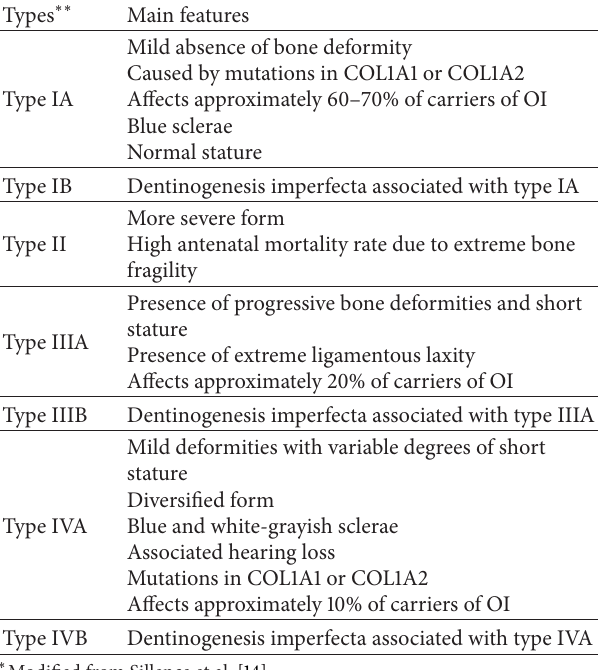
Table 1: Classification of osteogenesis imperfecta into the four most frequent types ∗